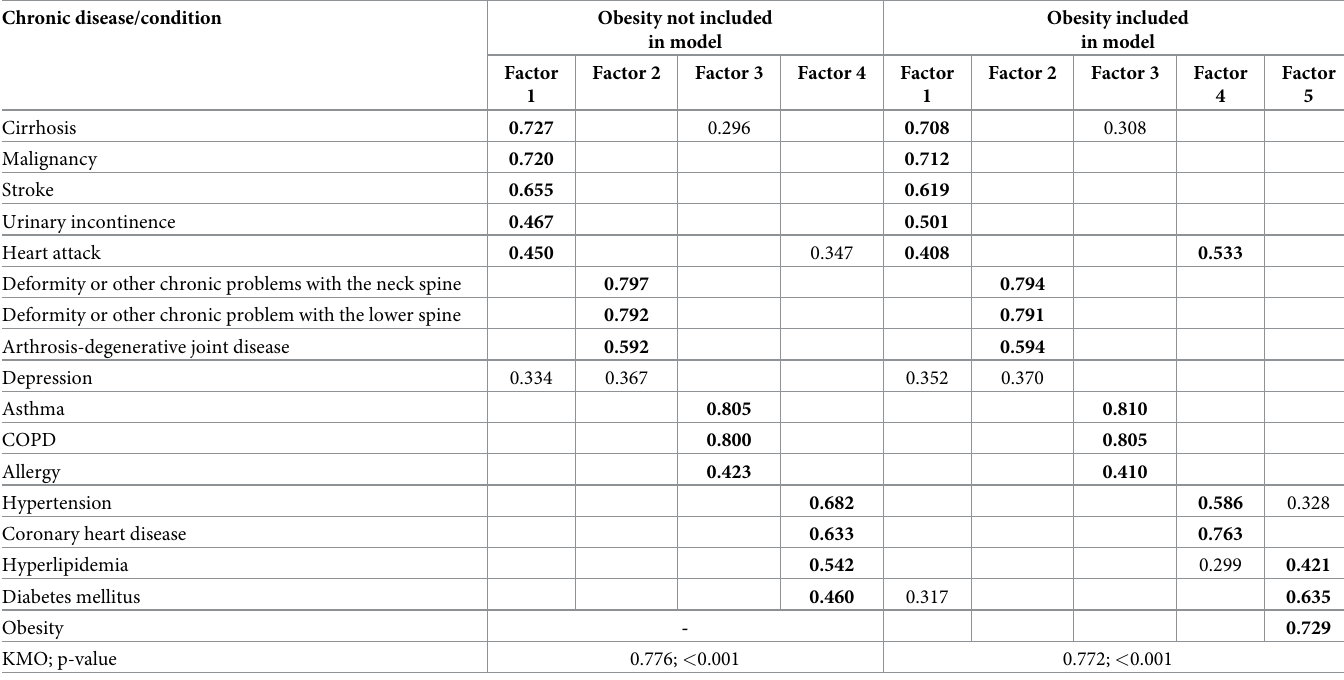
Table 3. Factor scores for the co-occurrence of chronic diseases/conditions in respondents who reported presence of kidney disease, Republic of Serbia,